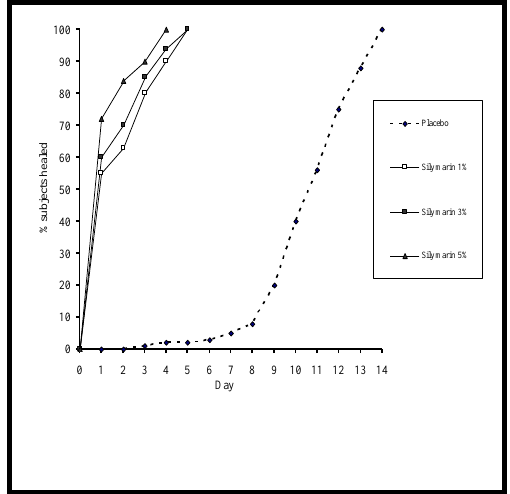
Figure 1. Effects of treatment with silymarin paste on ulcer healing time in HLU patients. All results are significantly different ( P <0.05) compared to placebo within 3-5 days.